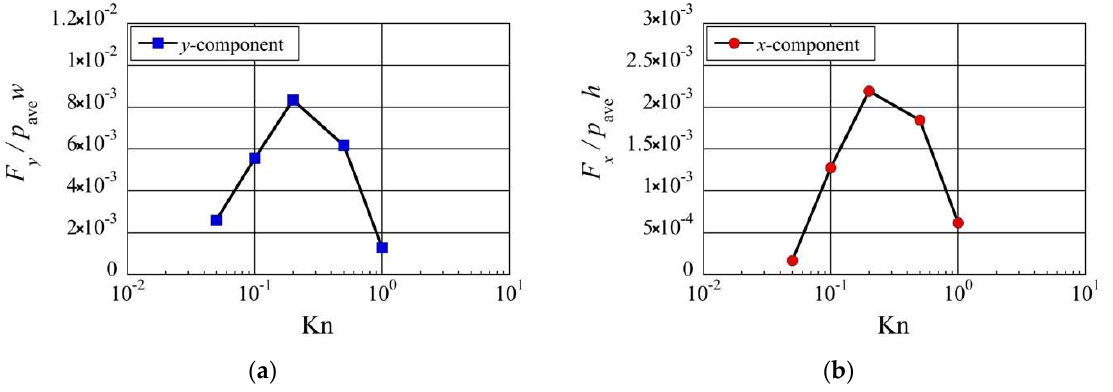
Figure 13. Net ( a ) upward and ( b ) rightward forces exerted on the beam at different Knudsen num- bers.